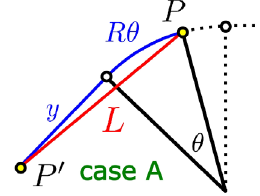
FIG. 1. Geometry for case A. Point P and P 0 are labeled by yellow dots. The blue curve is the path traversed by electrons. These conventions apply to all other geometry figures in Sec.